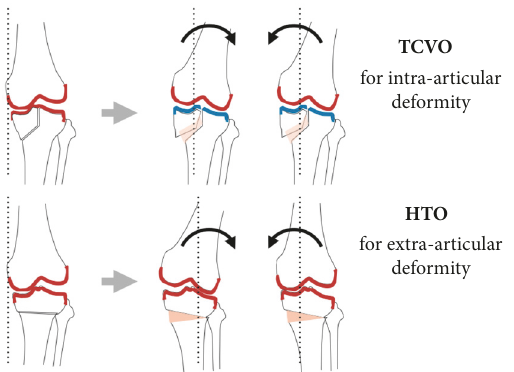
Figure 8: TCVO can reconstruct the joint congruency and alignment, however, HTO change only static lower limb alignment. Teeter effect cannot be improved by HTO.